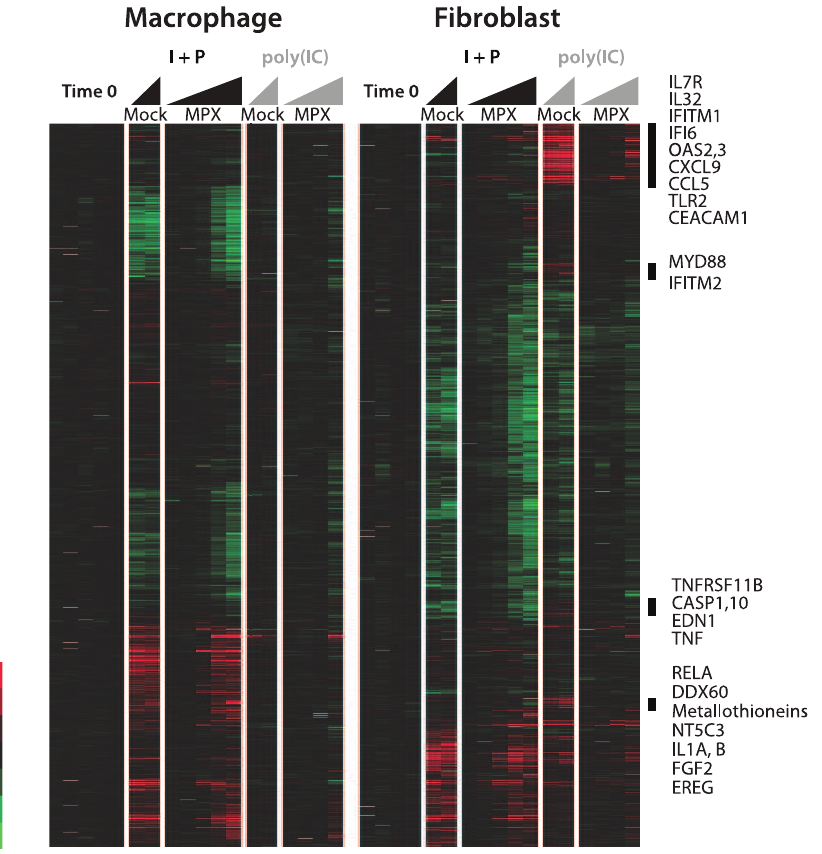
Figure 3. Effects of infection with MPV on the transcriptional responses of fibroblasts to poly-IC or PMA + ionomycin. (A) Fibroblasts were infected with MPV at an MOI of 10, or mock-infected, 4 hours prior to treatment with either poly(I-C) or PMA + ionomycin. Cells were harvested and RNA samples analyzed at 12 and 24 hours after treatment of mock-infected cells (16 and 28 hours after mock-infection), at 1, 2, 6 and 12 hours after poly(I-C) treatment (5, 6, 10 and 16 hours after MPV infection), and at 1, 2, 6, 12 and 24 hours after PMA and ionomycin treatment (5, 6, 10 and 16 hours after MPV infection) of MPV-infected cells. The samples from each time course are ordered from left to right. For this display, genes were clustered and expression levels represented by a color scale as in Figures 1 and 2. The brightest red and green colors in this display correspond to increases or decreases in transcript abundance by factors of at least 32 relative to time zero. Mock=mock infection (media only), MPV=Monkeypox- Zaire, I + P=treated with ionomycin and PMA 4 hours after infection or mock-infection, Poly(I-C)=treated with poly(I-C) 4 hours after infection or mock-infection. Names of a few selected genes from 4 clusters, all induced by poly(I-C) in the mock-infected cells but not in the MPV-infected cells, are indicated to the right of the corresponding clusters, marked by the vertical black lines. For a comprehensive, browseable view of the gene expression programs depicted here, see the supporting information. The complete raw data from this experiment are available at: www.smd. stanford.edu or the GEO database (accession number